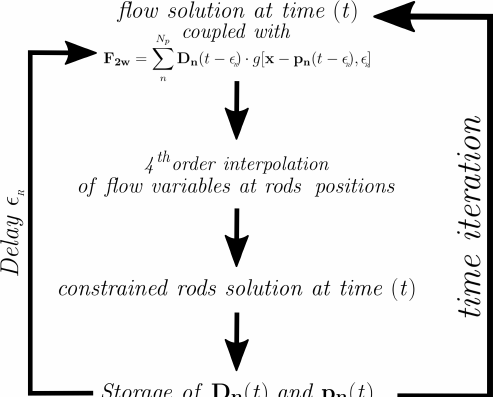
Figure 6. Schematic representation of the method of study: all the simulations performed in this study start from a random dispersion of mean-flow-aligned fibers at a given volume fraction in fully-developed turbulent channel flow. Then, the calculations are advanced in time, storing the instantaneous position of each fiber element, p n , and the drag force experienced by the element, D n over a time window whose length is given by the ratio between the delayed time scale (cid:101) and the value for the time step, dt . Once one full delayed time scale has expired, the two-way coupling term F 2 w can be calculated and added as a source term in the governing equations for the fluid, 1 a , b . The loop is then repeated until the end of the